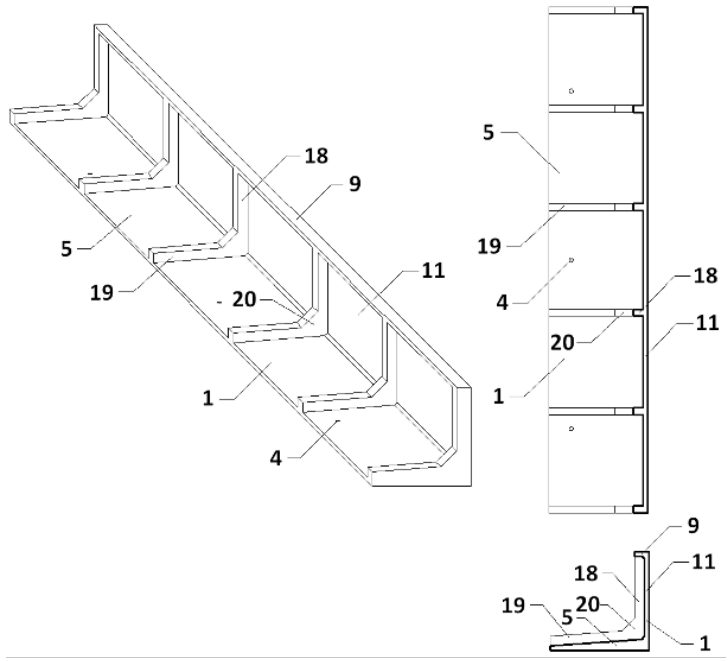
Figure 4. Precast parapet block. Notes : 1 - parapet block, 4 - anchoring of parapet block, 5 - horizontal part of parapet block, 9 - the upper part of the parapet block, 11 - vertical part of parapet block, 18 - vertical reinforcement rib of parapet block, 19 - horizontal reinforcement rib of parapet block, 20 - rib